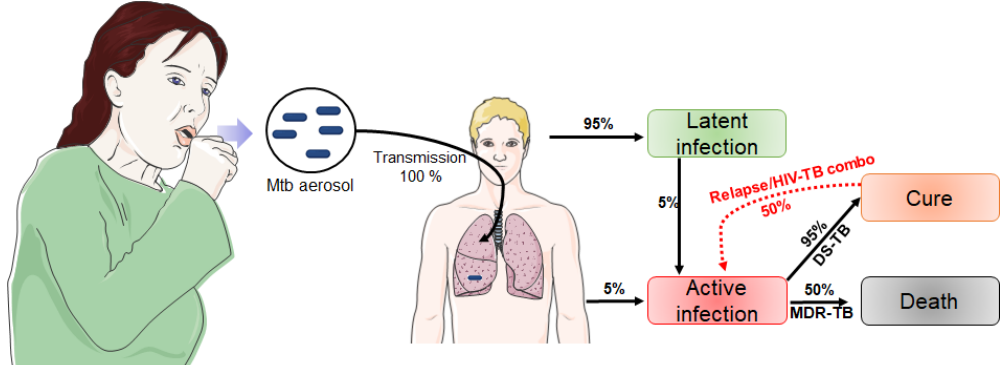
Figure 1. Stages of Mtb transmission and infection cycle showing that 95% of infected patients will have the latent form, and 50% of relapse cases will go directly from latent to active form (only 5%